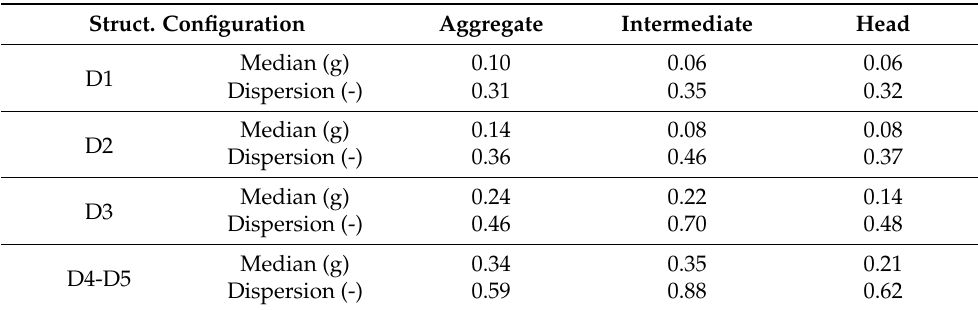
Table 5. Median and dispersion values for the examined typological fragility functions. Struct. Configuration